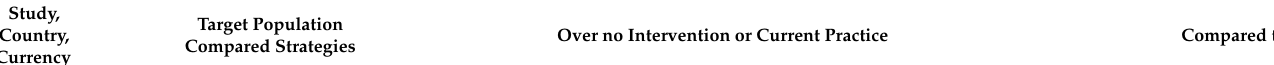
Table 4. Discounted Costs, Life Years, QALYs, and Incremental Cost-E ff ectiveness Ratios of Risk-Reducing Interventions for Women at Increased or High Risk for Endometrial